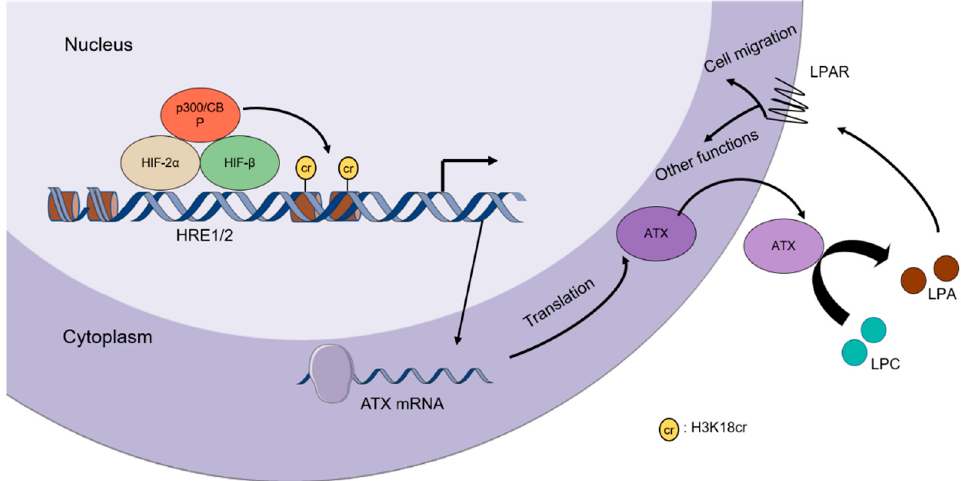
Figure 8. Schematic representation of the proposed ATX expression regulation mechanisms during hypoxia. Under hypoxic conditions, HIF-2 α is stabilized and interacts with HIF- β to form a heterodimer, which can bind to the functional hypoxia-response elements (HREs) in the ATX promoter and recruit p300/CBP to the ATX promoter. p300/CBP-mediated histone crotonylation induces ATX expression, leading to the elevation of extracellular LPA levels to promote cell migration through LPA receptors on the cell surface. LPAR, LPA receptor.